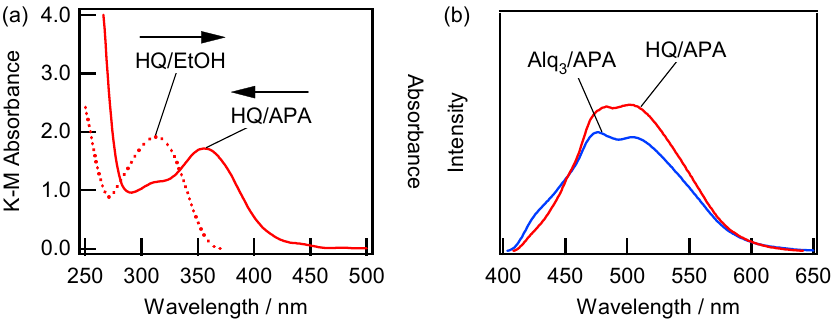
Figure 5. ( a ) Absorption spectra obtained for the HQ/EtOH (1 mM) and HQ/APA (v) systems; and ( b ) fluorescence spectra recorded for the Alq 3 /APA and HQ/APA (v) samples. The excitation wavelength was 350 nm.